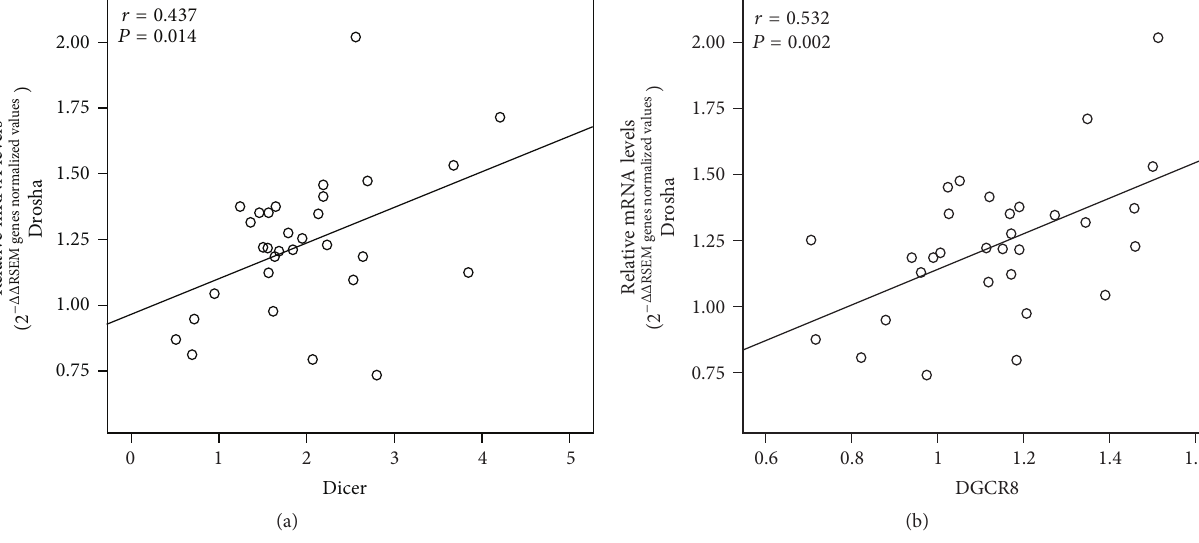
Figure 4: Correlation between mRNA expression levels of individual components in TCGA PTC data. Correlations were found between Dicer and Drosha and between Drosha and DGCR8; ∗ 𝑃 = 0.014 and ∗∗ 𝑃 = 0.002 ,